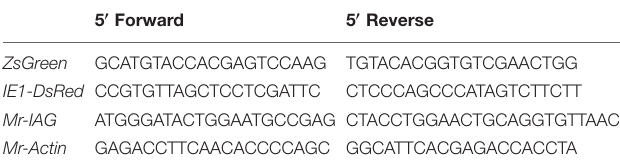
TABLE 1 | Specific primer sequences for PCR